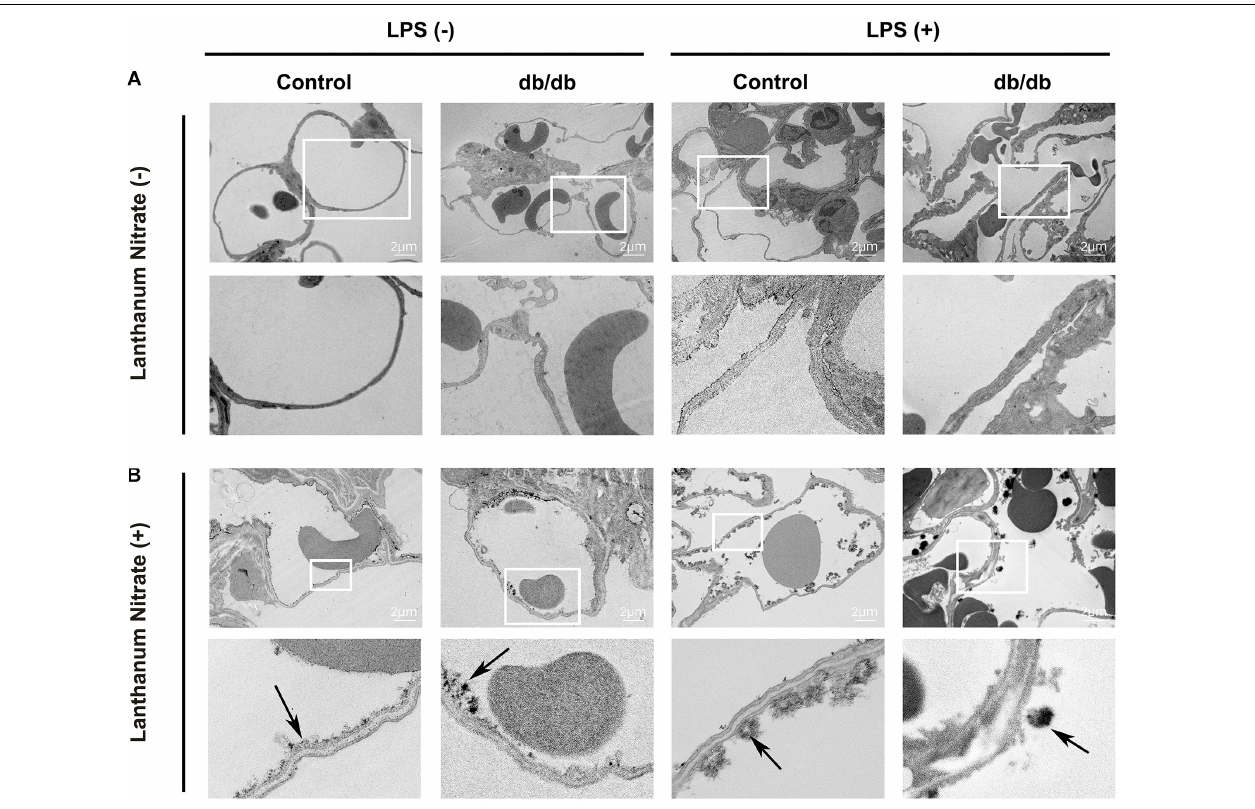
FIGURE 6 | Ultrastructural imaging of pulmonary endothelial injury by transmission electron microscopy (TEM). (A) Images taken from samples not stained with lanthanum nitrate; the endothelial glycocalyx was not detected. The pulmonary endothelium was thin and smooth in control mice before LPS injection. In control mice after LPS injection, the endothelial wall became edematous, but the extent of this was greater in db/db mice than in control mice treated with or without LPS. (B) The endothelial glycocalyx was detected using lanthanum nitrate staining. The endothelial glycocalyx structure showed greater degradation in db/db mice than in control mice under normal conditions. After LPS injection, the endothelial glycocalyx formed a skip lesion in control mice, whereas the endothelial glycocalyx was more degraded in db/db mice. Black arrows indicate the endothelial glycocalyx.